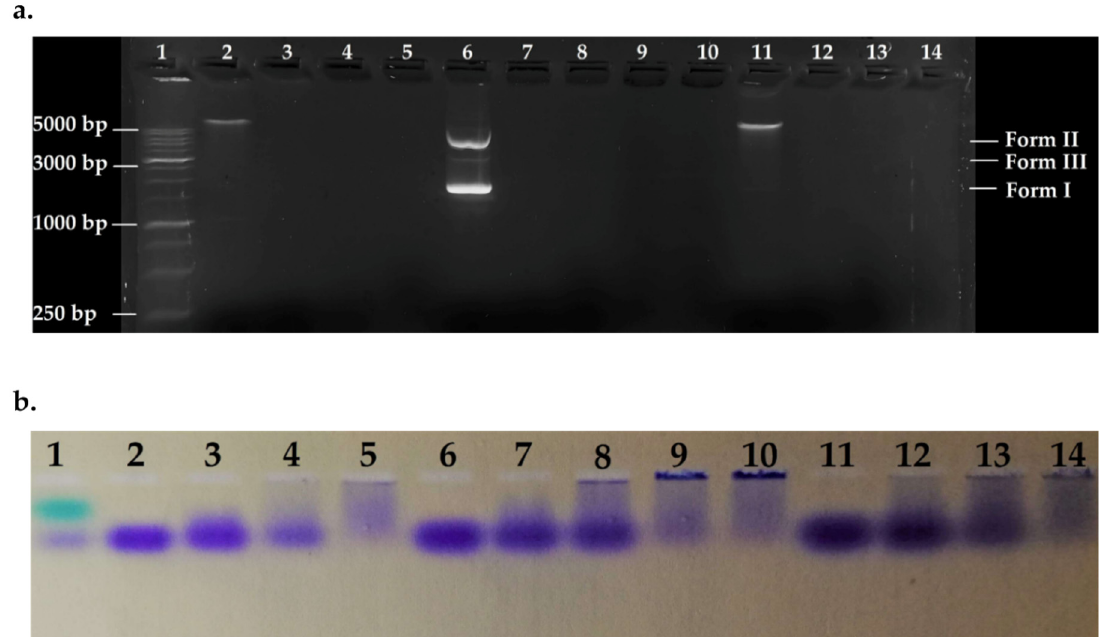
Figure 5. Agarose gel electrophoretic pattern. Lane 1: HyperLadder 1 kb (15 μ L); Lane 2: gDNA1;